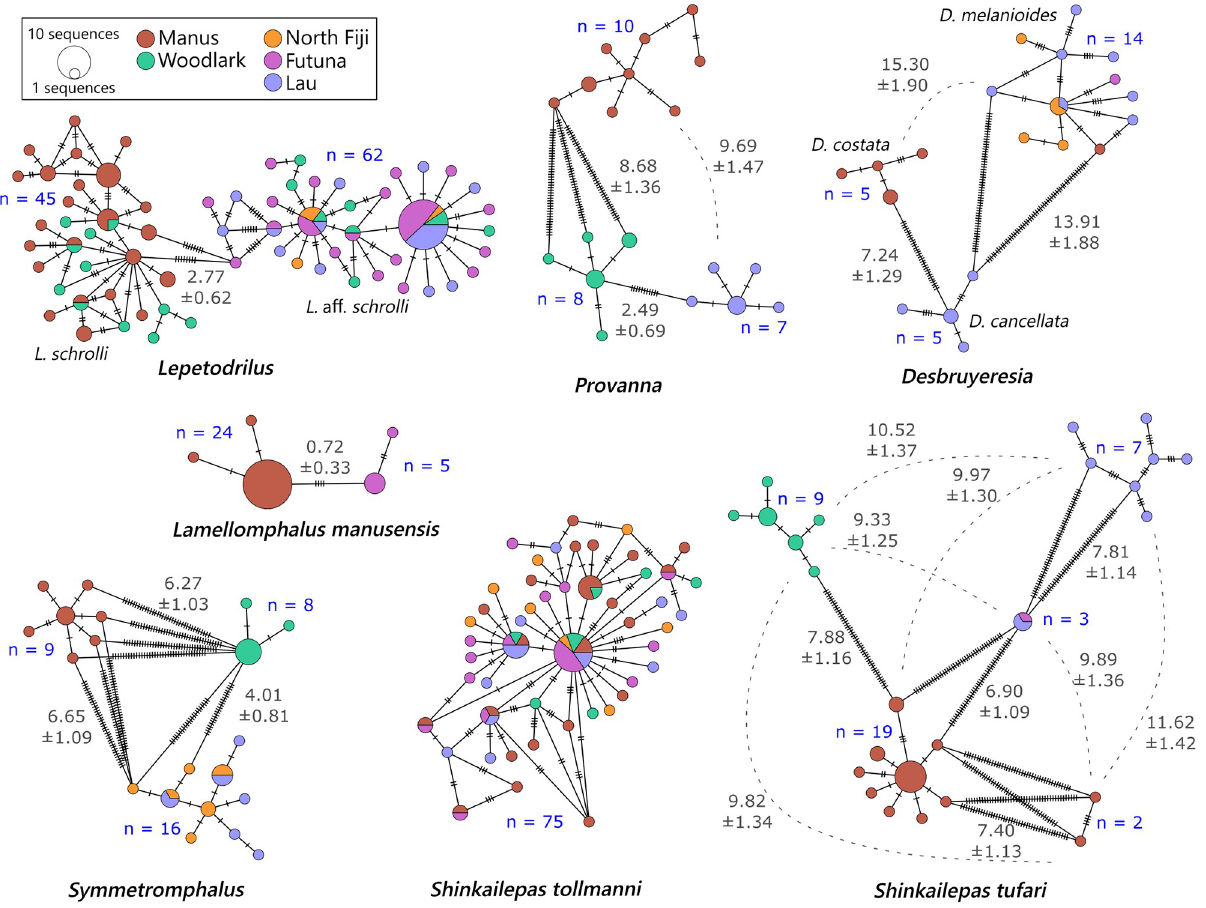
Fig 3. Minimum Spanning Networks based of Cox1 haplotypes from each taxon. Circles represent the different haplotypes; their diameter indicates the number of individuals with the same haplotype and colour their location. Mutational steps are symbolised by dashes. n = number of sequences within each lineage. Grey numbers represent the divergence between the different lineages (mean K2P% ± Sd).